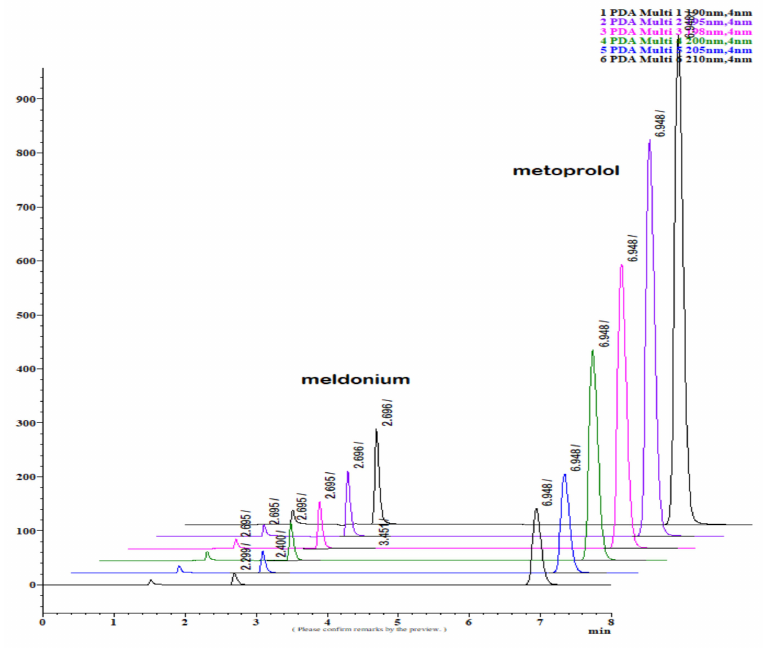
Figure 17. Full view-chromatogram of sample 2.5 mg/mL meldonium and 0.5 mg/mL metoprolol with Waters Spherisorb CNRP-250 × 4.6 mm eluted 0.15% NH 4 H 2 PO 4 + 50% ACN full chromatogram